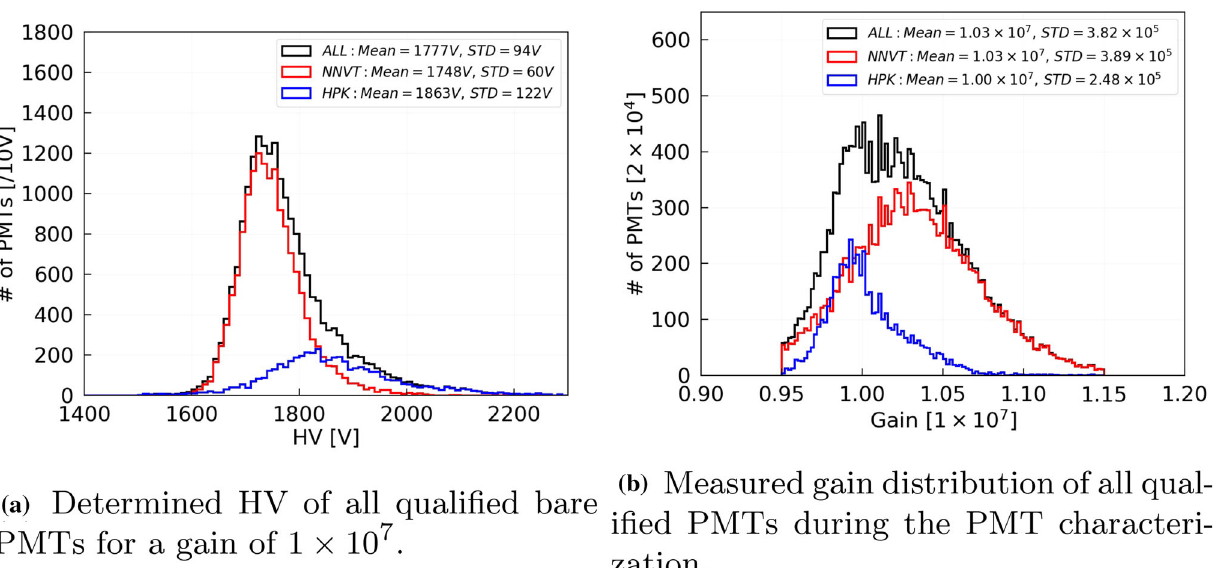
Fig. 12 Determined HV and gain of all qualified PMTs. Measured gains not contained in [ 0 . 95 , 1 . 15 ] × 10 7 lead to a retest of the corresponding PMT. Black: all PMTs; red: NNVT; blue: HPK